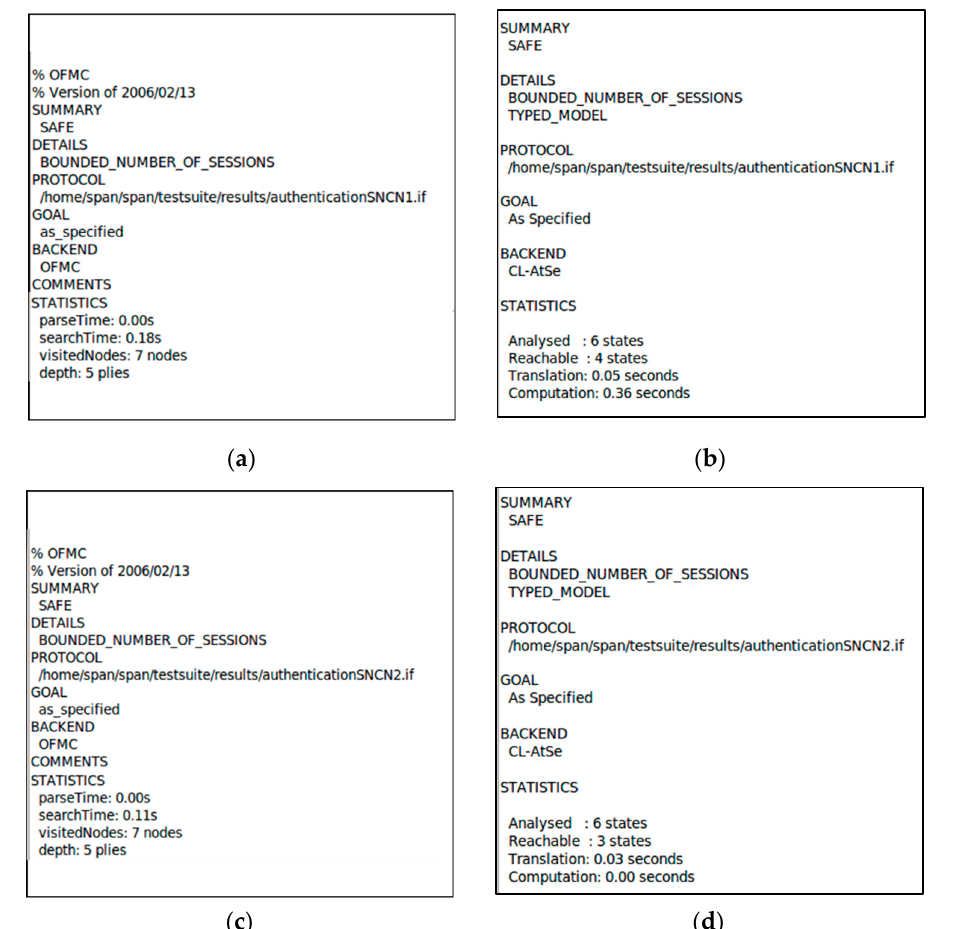
Figure 11. SPAN animator of protocol-II.